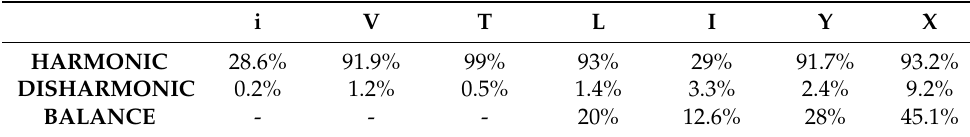
Table 3. Covered areas for each experiment related to the